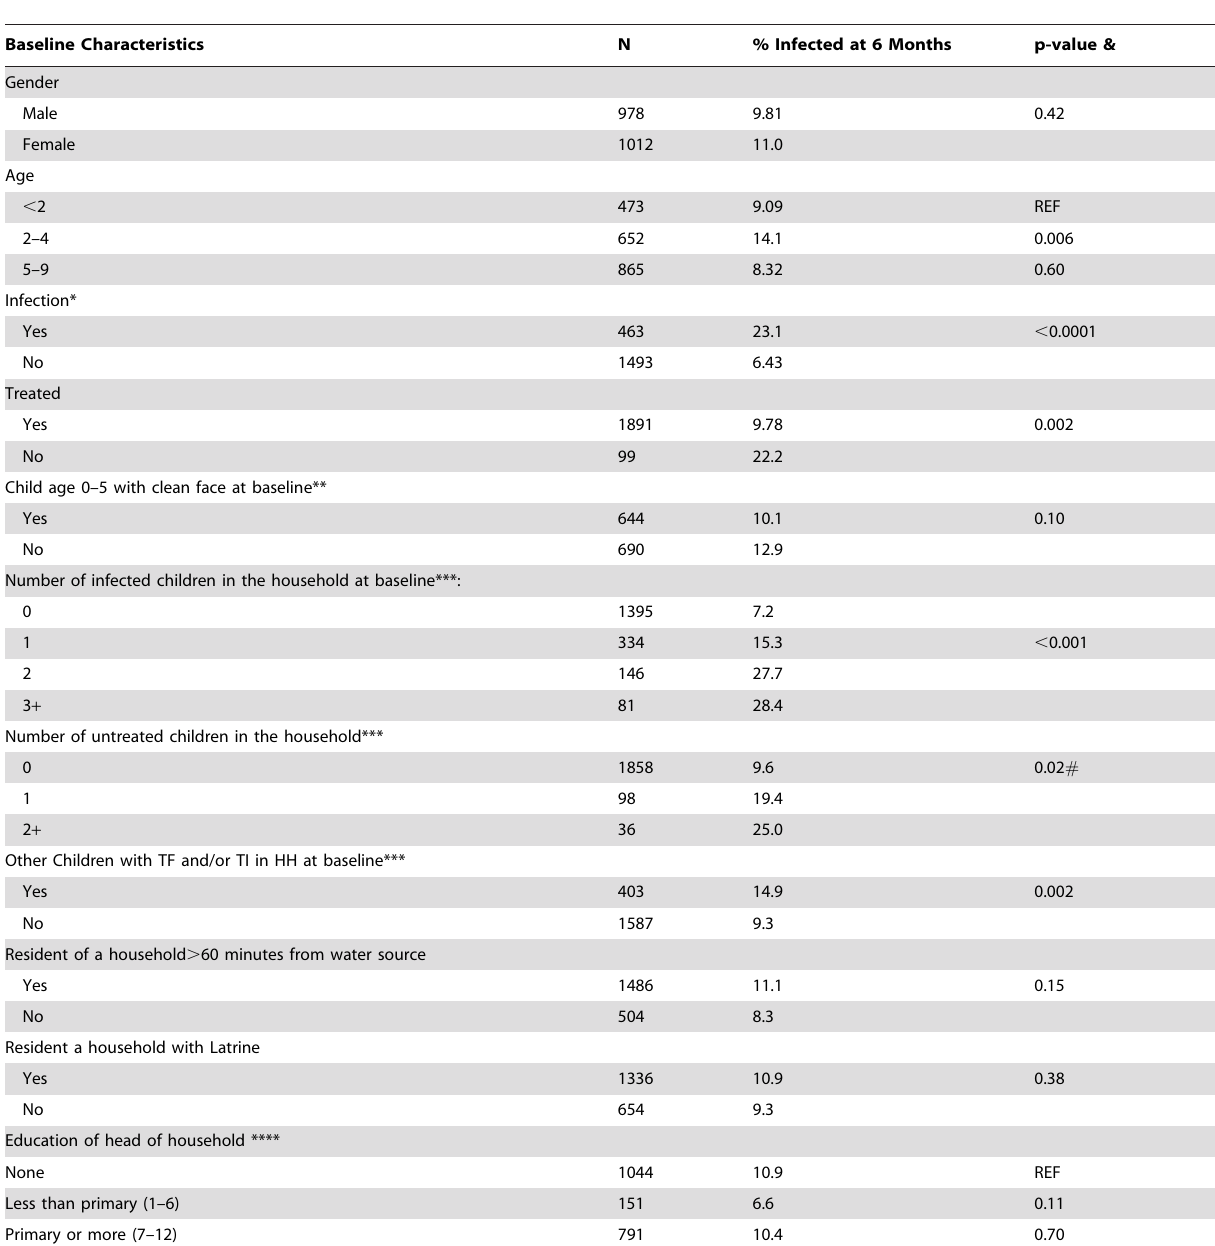
Table 2. Baseline Characteristics of the Cohort and percentage infected at 6